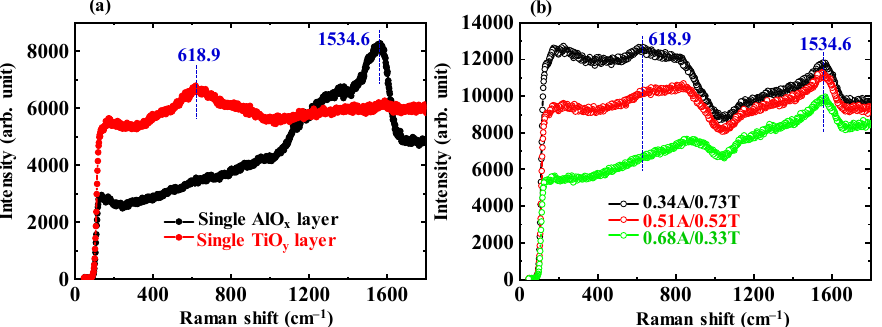
Figure 3. Raman spectra for ( a ) AlO x and TiO y single layers and ( b ) 0.34A/0.73T, 0.51A/0.52T, and 0.68A/0.33T ATO NLs.